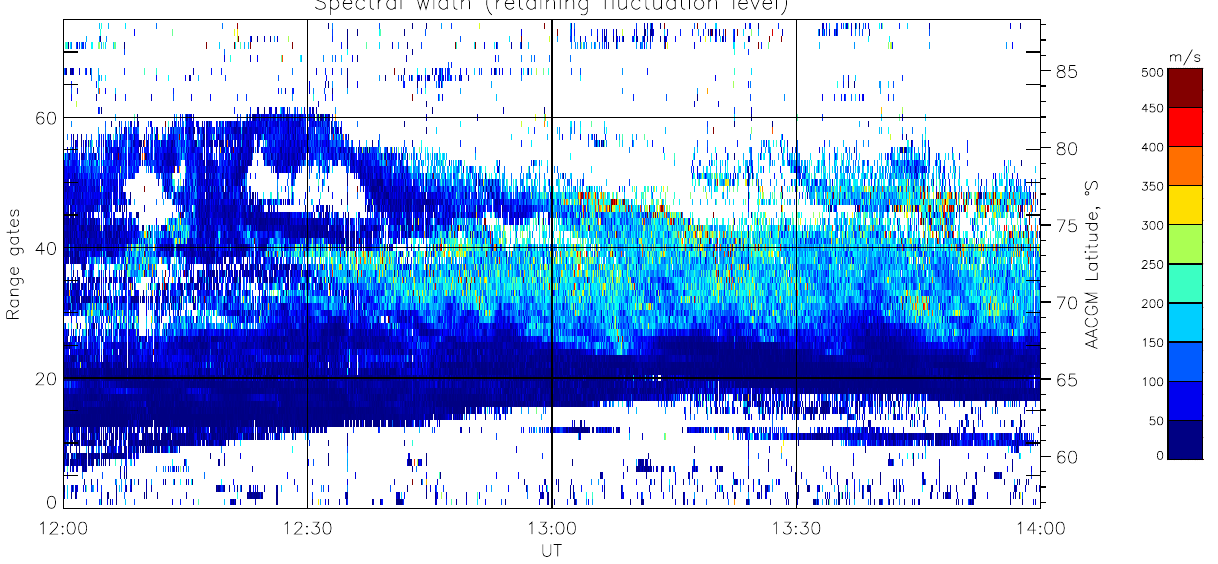
to both log | R(τ) | (solid line) and log ( | R(τ) |− σ R )